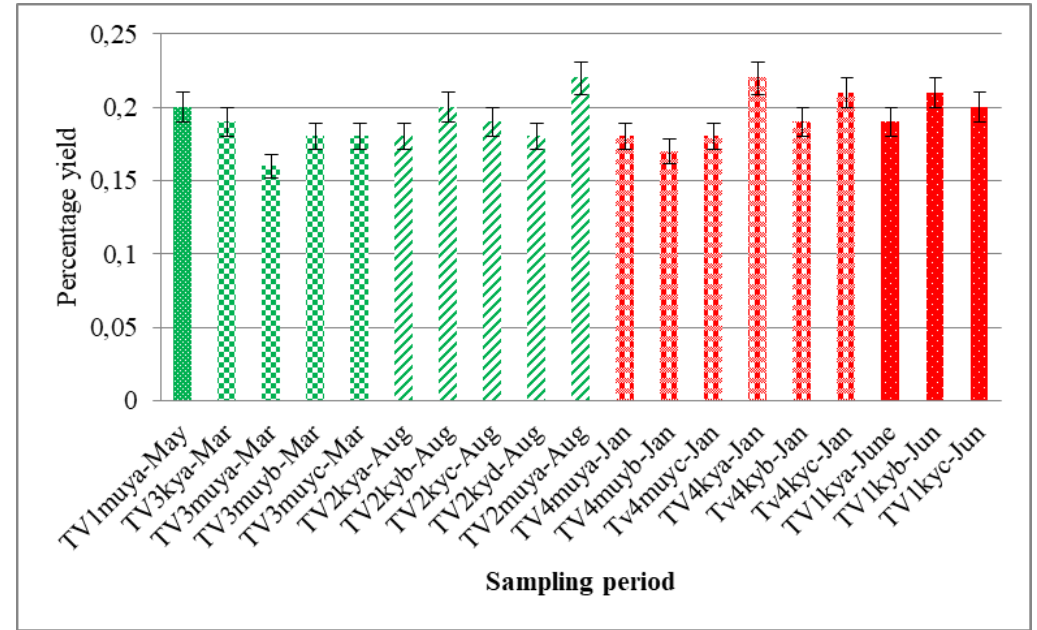
Figure 3. A continuous histogram depicting the percentage yield of the oils from samples of T. vogelii.